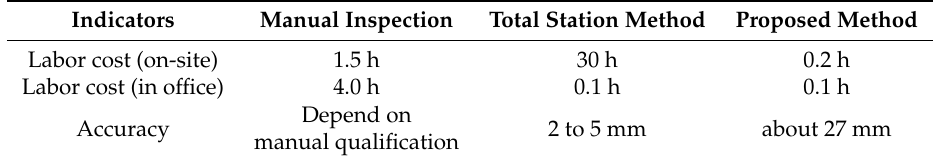
Table 6. Comparison of inspection methods for a metro tunnel (per